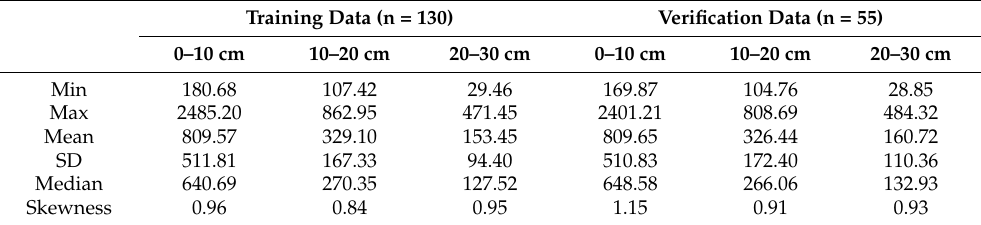
Table 2. Descriptive statistics for grassland root biomass in the training data and verification data (g m − 2